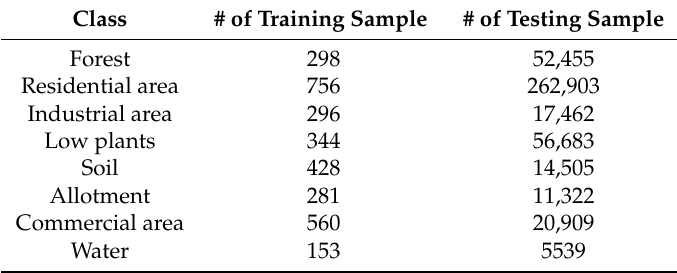
Table 2. Summary of the training data and the testing data for the scene of city